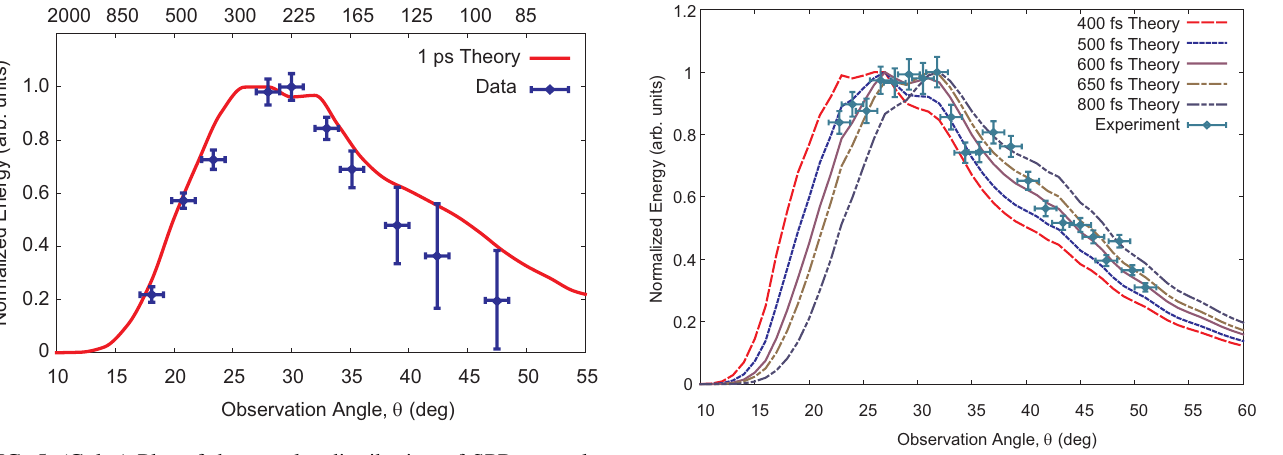
FIG. 7. (Color) Plot of the angular distribution of SPR normal- ized energy from the 6 mm grating as measured by the Si bolometer. The theoretical curve is shown for a 15 MeV beam with various Gaussian longitudinal distributions, and 1 mm FWHM Gaussian transverse